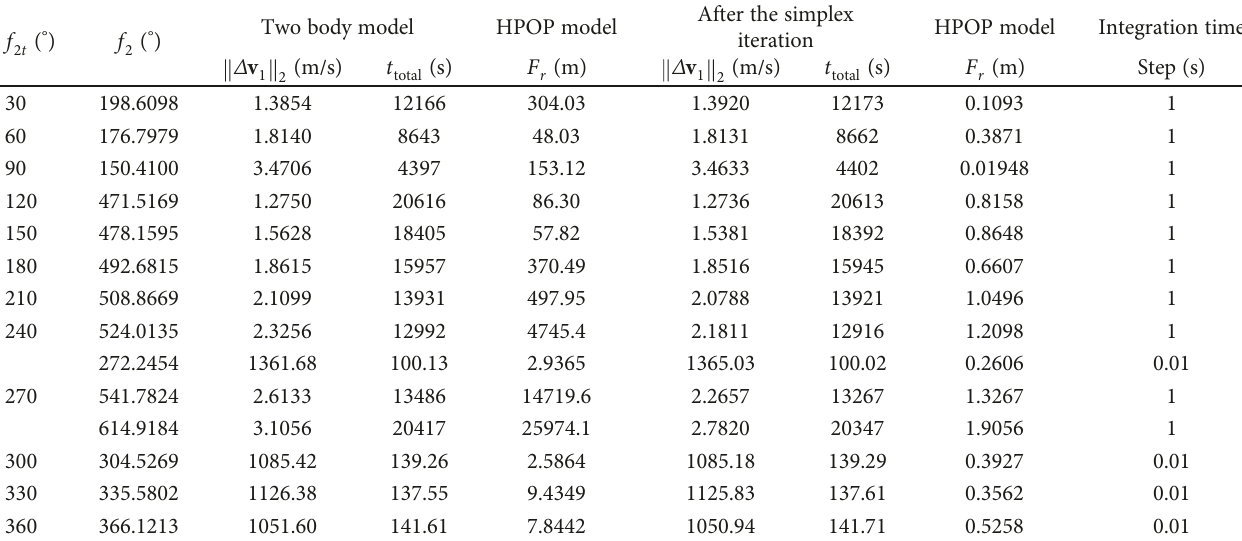
Table 2: Tangent impulse interception solutions at di ff erent impulse